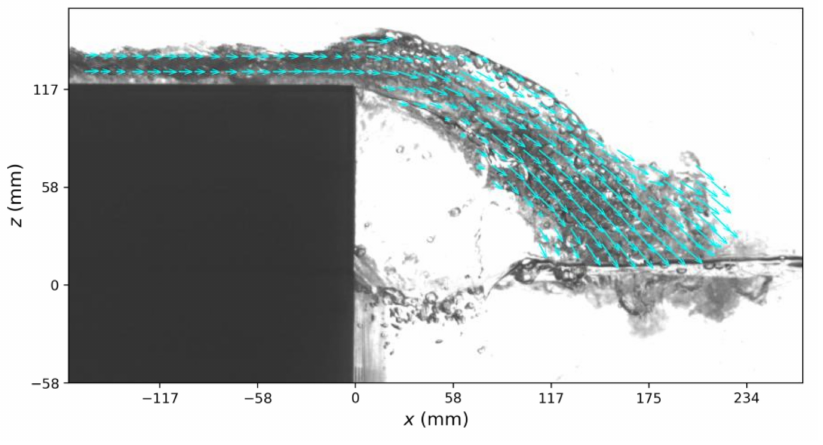
Figure 5. Snapshotofthevelocitymapofwaveovertoppingflowplungingontherearsideofthebreakwater.